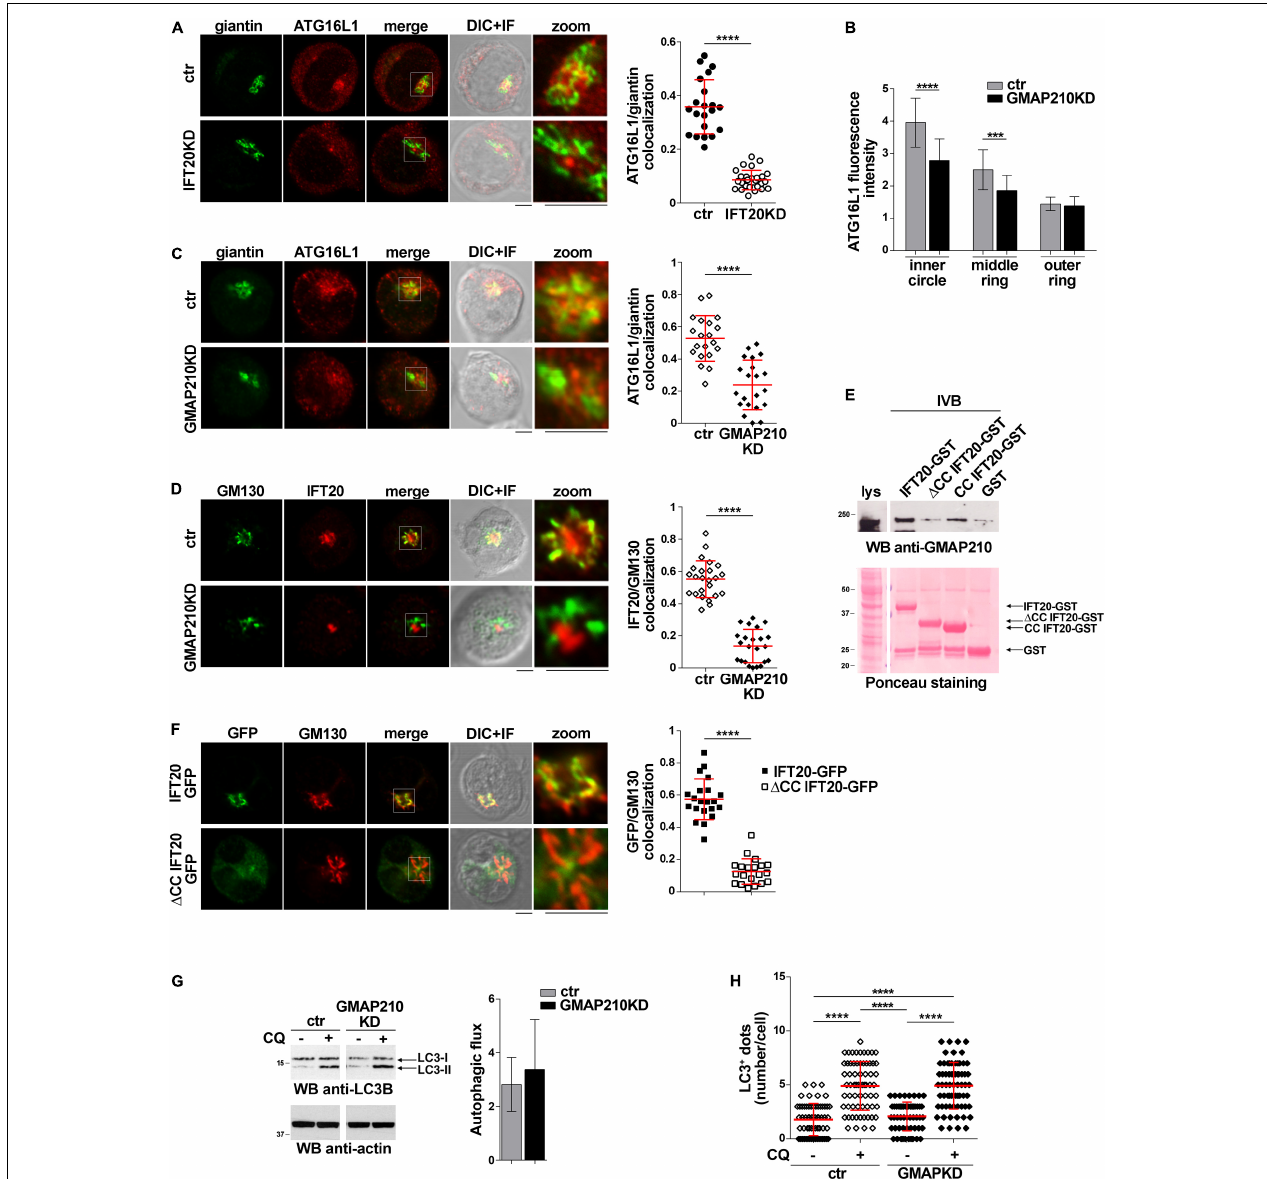
FIGURE 3 | IFT20 couples ATG16L1 to the Golgi through its CC domain-mediated interaction with GMAP210. (A) Quantification using Mander’s coefficient of the weighted colocalization of ATG16L1 and the Golgi marker giantin in ctr and IFT20KD Jurkat cells ( ≥ 21 cells/sample, n = 3; mean ± SD; Student’s t -test). Representative images (medial optical sections and the overlay DIC + IF) are shown. Scale bar: 5 µ m. (B) Quantification of fluorescence intensity of ATG16L1 in the concentric regions previously described ( Figure 2B ) in control and GMAP210KD cells (mean ± SD, ≥ 25 cells/sample; n = 3; Mann–Whitney test). (C,D) Immunofluorescence analysis of ATG16L1 and giantin (C) or IFT20 and the Golgi marker GM130 (D) in control and GMAP210KD cells. Representative medial optical sections and overlay of immunofluorescence (IF) and differential interference contrast (DIC) images are shown (IF + DIC). The graph shows the quantification (using Mander’s coefficient) of the weighted colocalization of ATG16L1 and giantin (C) or IFT20 and GM130 (D) . The data are expressed as mean ± SD ( ≥ 20 cells/sample; n = 3; Mann–Whitney test). Scale bars: 5 µ m. (E) Immunoblot analysis with anti-GMAP210 antibodies of in vitro -binding assays carried out on post-nuclear supernatants of Jurkat cells using IFT20-GST, (cid:49) CC IFT20-GST and CC IFT20-GST fusion proteins, or GST as negative control. The Ponceau red staining of the same filter is shown to compare the levels of fusion proteins and GST used in the assay. The immunoblot shown is representative of three independent experiments. (F) Quantification (using Mander’s coefficient) of the weighted colocalization of the cis -Golgi marker GM130 with GFP in medial confocal sections of IFT20-GFP or (cid:49) CC IFT20-GFP expressing Jurkat cells (mean ± SD; ≥ 20 cells/line; n = 3; Mann–Whitney test). Representative images (medial optical sections and overlay DIC + IF) are shown. Scale bar: 5 µ m. (G) Immunoblot analysis of LC3B in lysates of control or GMAP210KD cells in the presence or absence of chloroquine (CQ, 40 µ M). The migration of molecular mass markers is indicated. The histograms show the autophagic flux calculated as the difference in the levels of LC3II/actin between CQ-treated and CQ-untreated samples (mean fold ± SD; Student’s t -test; n ≥ 3). (H) Quantification of the number of LC3 + dots/cell in control or GMAP210KD cells either untreated or treated for 30 min with chloroquine (CQ, 40 µ M). At least 35 cells from three independent experiments were analyzed (mean ± SD; Kruskal–Wallis test). ** P < 0.01; *** P < 0.001; **** P < 0.0001.